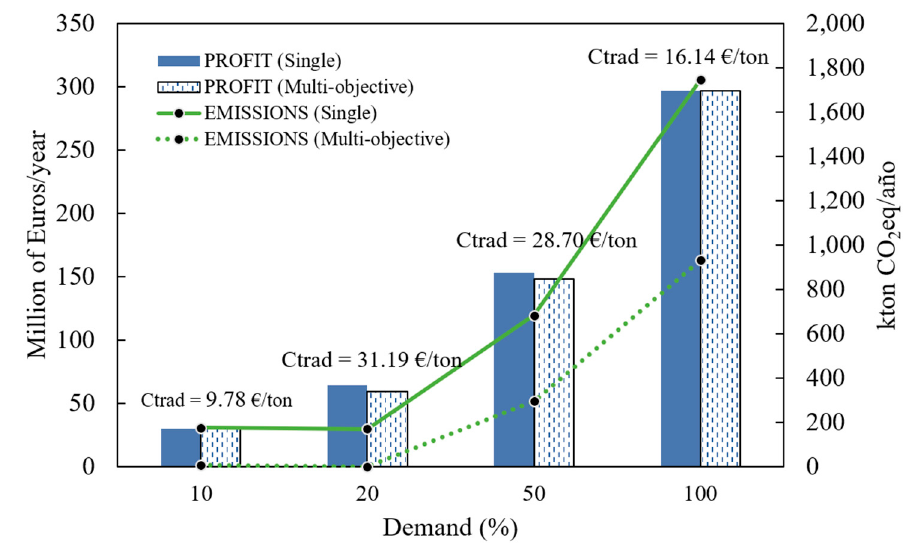
Figure 8. Results for multi-objective formulation using carbon emission trading (Case 3). Table 3. Broken-down results for multi-objective formulation.